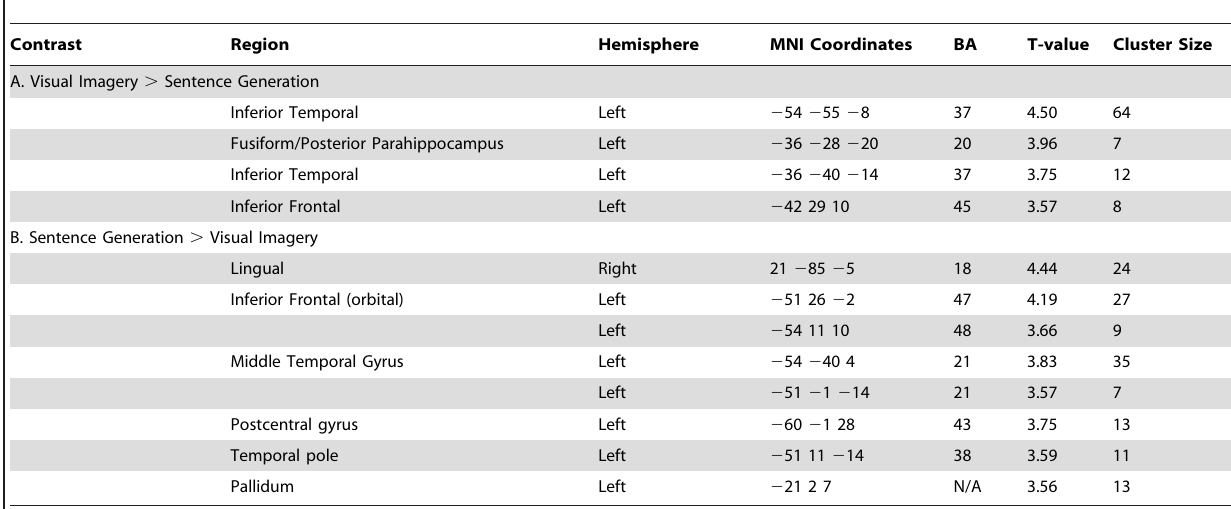
Table 2. Regions showing the task main effect at the time of study for the visual imagery condition (A) and the sentence generation condition